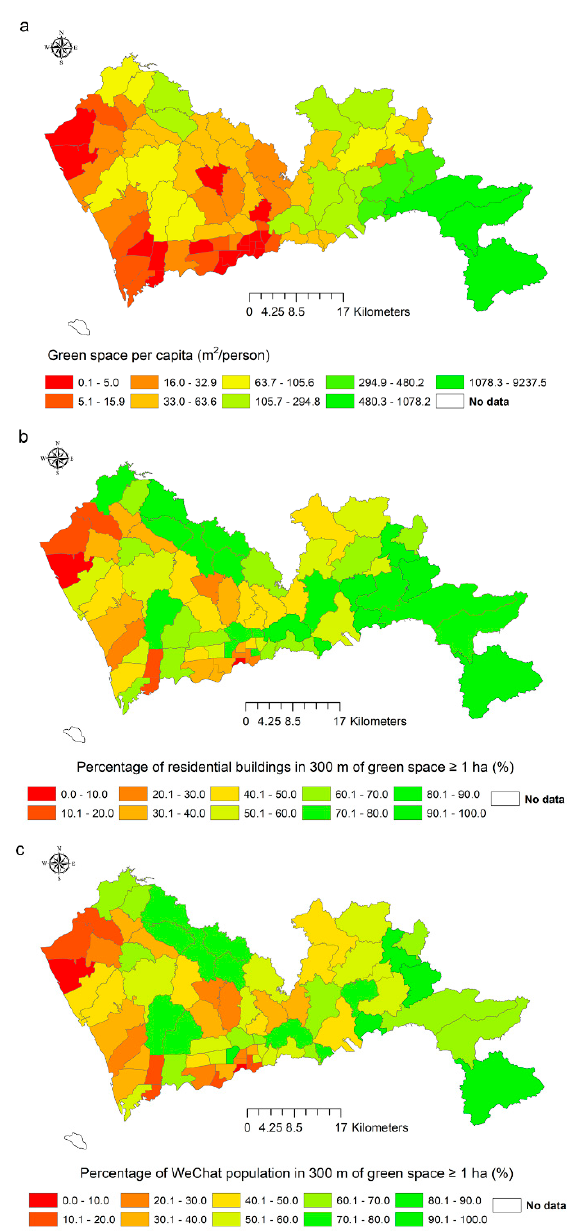
Figure 1. The indicator values of green spaces in 74 sub-districts. ( a ) The area of green space per capita; ( b ) the percentage of residential buildings < 300 m to a green space with a minimum size of 1 ha; ( c ) The percentage of WeChat population < 300 m to a green space with a minimum size of 1 ha.